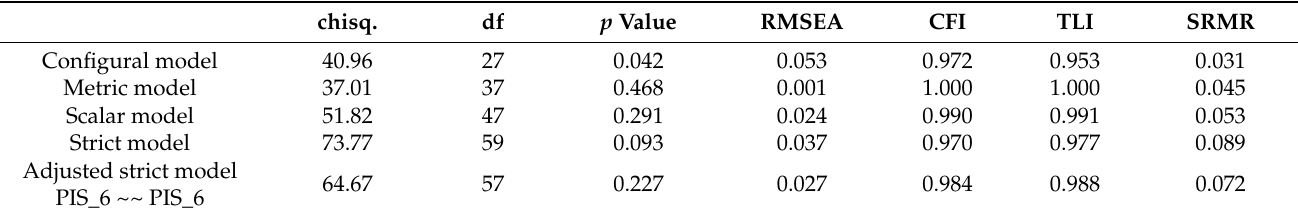
Table 8. Measurement invariance steps across age